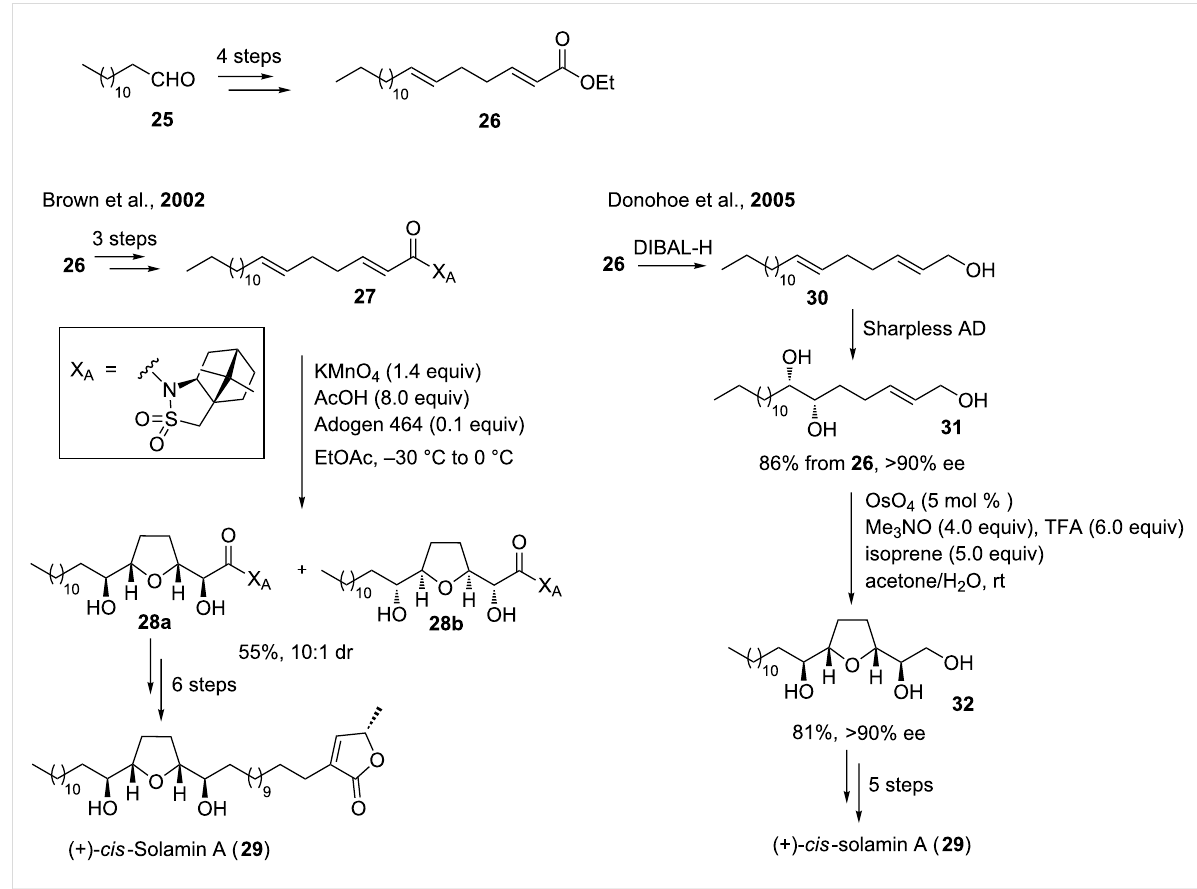
Scheme 8: Brown`s and Donohoe`s oxidative cyclization approach to cis -solamin A.